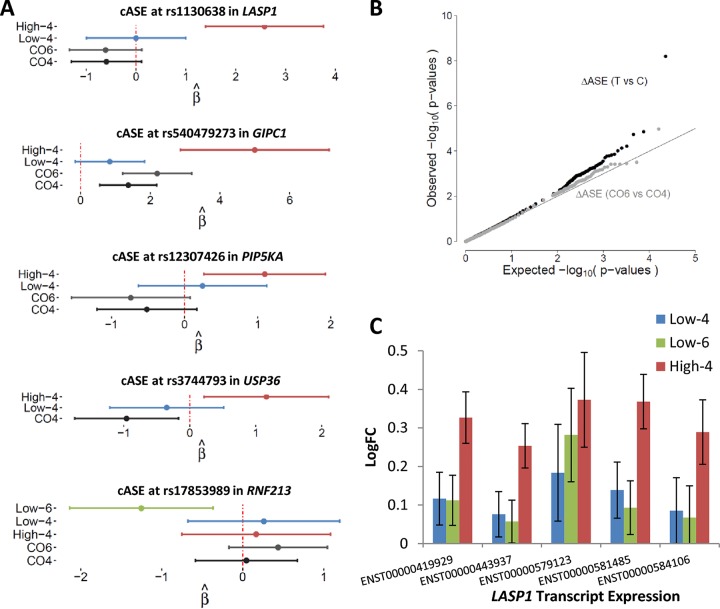
Gene-by-environment interactions in human colonocytes. (A) Forest plots depicting conditional cASE for 5 randomly chosen SNPs from the 12 with cASE (remaining are shown in Fig. S2C in the supplemental material). Allele-specific expression is shown for samples with at least 20 reads covering the indicated SNP (samples without 20 reads are not shown, as we could not accurately measure ASE). Positive β indicates allele-specific expression favoring the reference allele. (B) QQ-plot showing the nominal P values of SNPs that could be tested for cASE (20 reads covering SNP in both a treatment and the corresponding control or for both CO6 and CO4). (C) Gene expression changes in each treatment group (compared to the corresponding control) for each of 5 transcripts of LASP1 expressed in colonocytes. Error bars indicate standard errors for log2(fold change) among replicates.